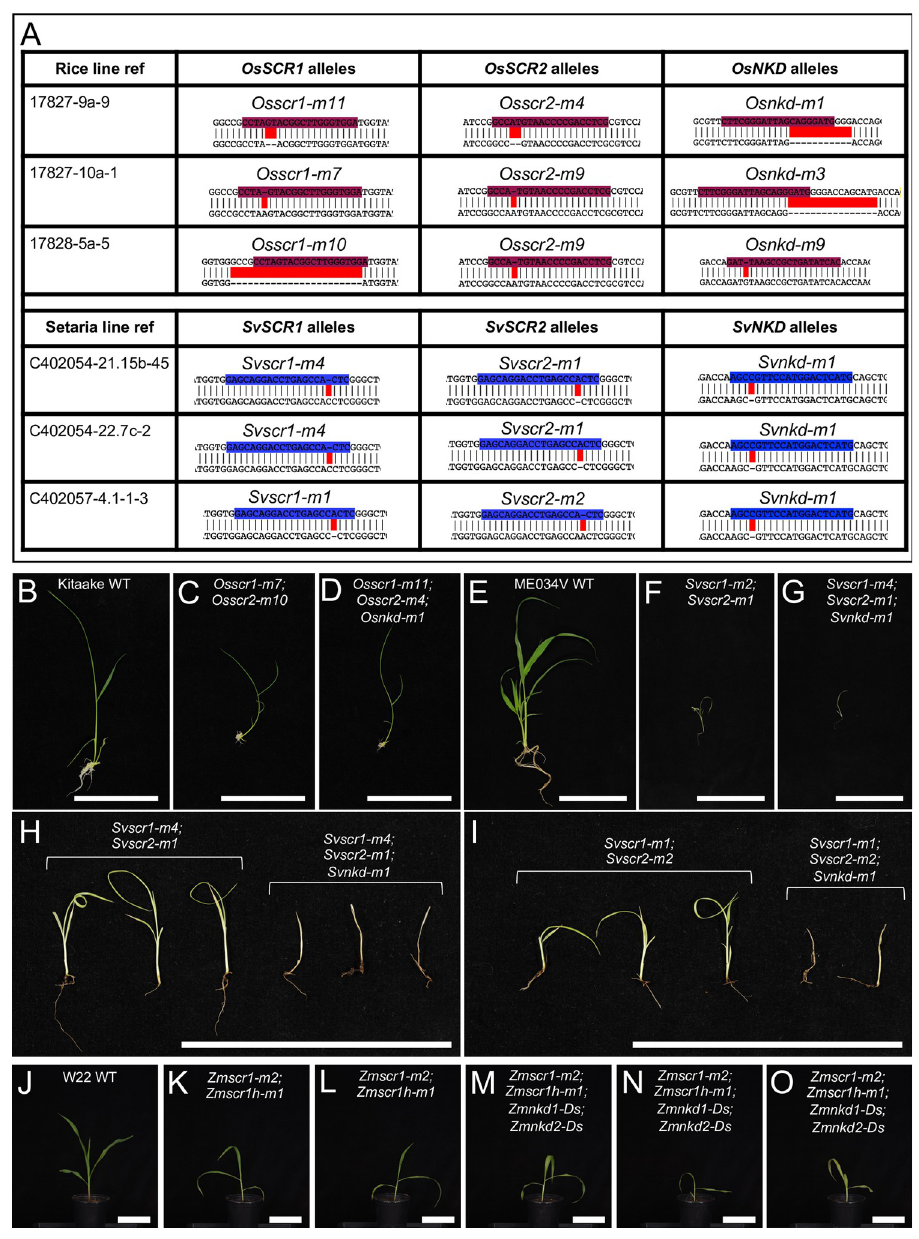
Fig 5. Loss of function nkd mutations enhance growth perturbations in scr mutants of setaria but not rice. A) Sequences of mutant scr1;scr2;nkd alleles in three independent lines of both rice and setaria. Wild-type sequences are shown above with guides highlighted in either maroon (rice) or blue (setaria). Edits are highlighted in red. Note Svscr1-m2 allele is included in Fig 1. B-O) Whole plant phenotypes of rice (B-D), setaria (E-I) and maize (J-O). Images were taken 14, 20 or 21 days after sowing for rice, setaria and maize respectively. Plants in (H) and (I) are from segregating families in each case, such that Svscr1;Svscr2 and Svscr1;Svscr2;Svnkd in each panel are siblings. Scale bars: 10cm.